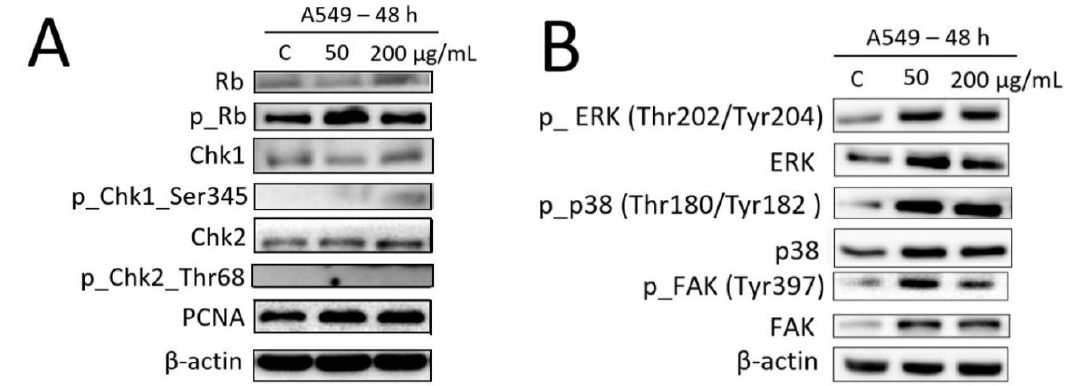
Figure 12. Western blot analysis of proteins that regulate cell cycle progression ( A ) and cell adhesion ( B ) in A549 lung carcinoma cells upon treatment with Fe 3 O 4 @SiO 2 -SH nanoparticles at 50 and 200 µg/mL for 48 h. Negative control cells were mock treated with 5% phosphate-buffered saline (PBS), indicated as C. These experiments were performed at least three times with similar results, and a cropped blot is shown from one representative experiment.